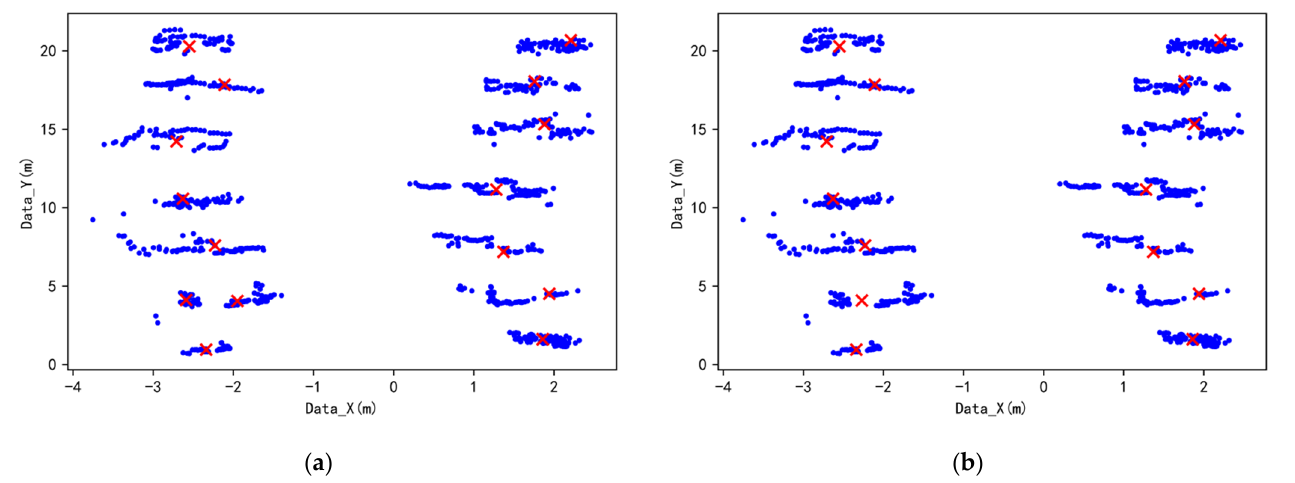
Figure 9. Algorithm detection results: ( a ) two cluster centers on a fruit tree; ( b ) results processed using this algorithm. Table 4. Two-dimensional LiDAR sensor parameters.